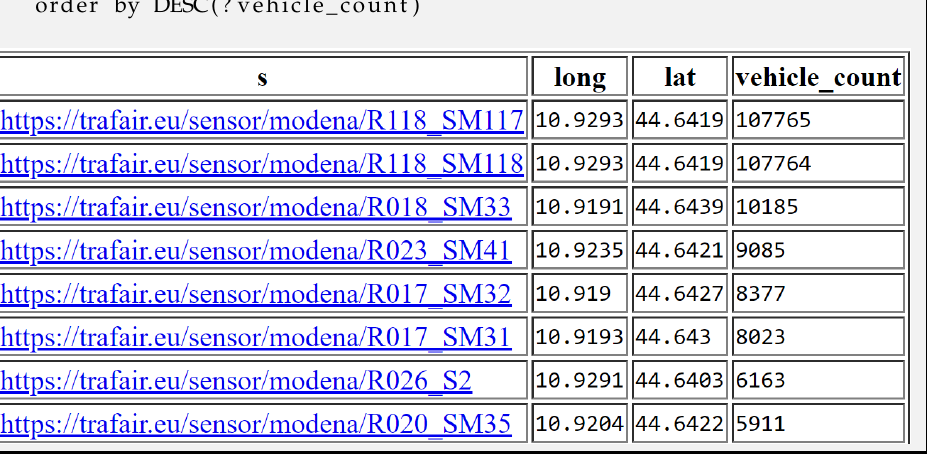
Figure 12. GeoSPARQL query showing the vehicle count of some sensors located in the town square of Modena on 8 January